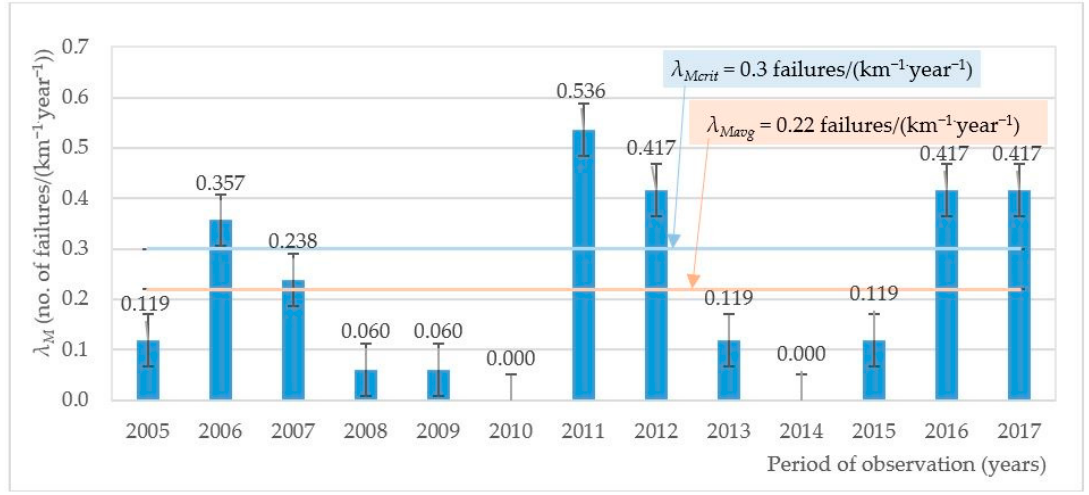
Figure 3. The failure rate for mains over the distinguished 2005–2017 period.